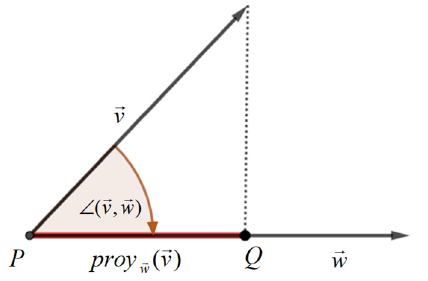
Figure 15. Geometric interpretation of the scalar product of two vectors.